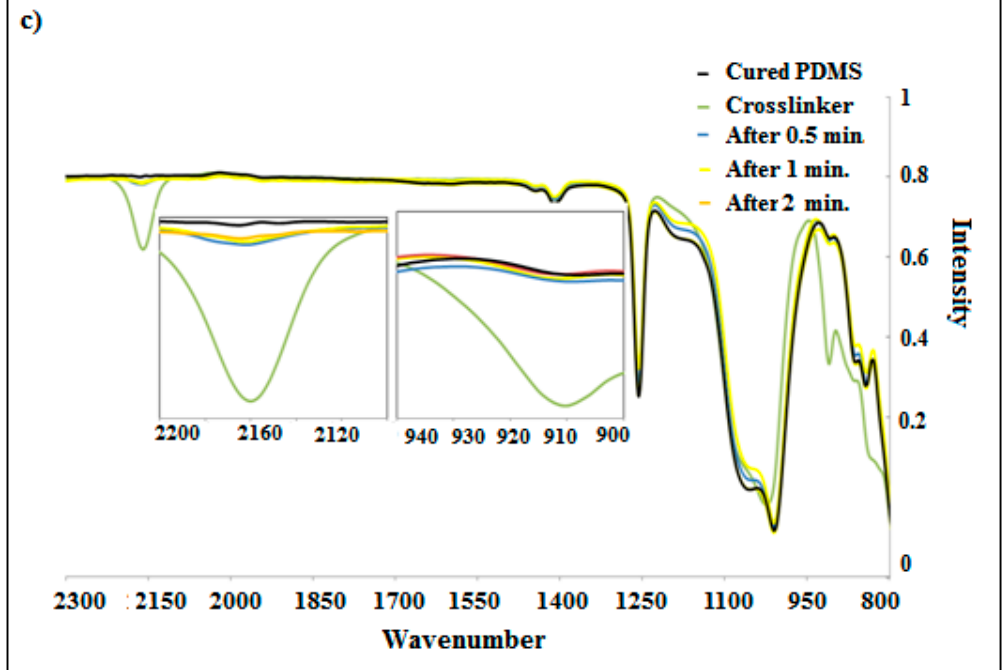
Figure 2. IR of consuming crosslinker at peaks 910 and 2160 cm − 1 with iron content in the composites ( a ) 5 wt %; ( b ) 10 wt %; and ( c ) 15 wt %.